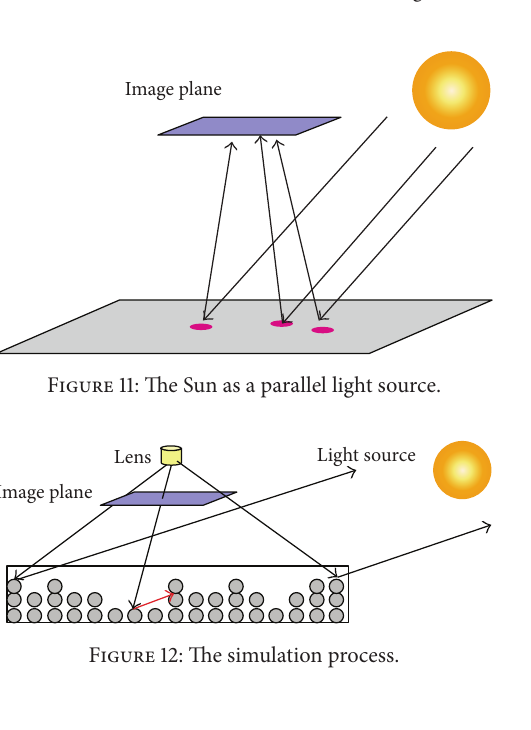
Figure 10: The distance between the Sun and the Moon is much longer than the radius of the Sun.